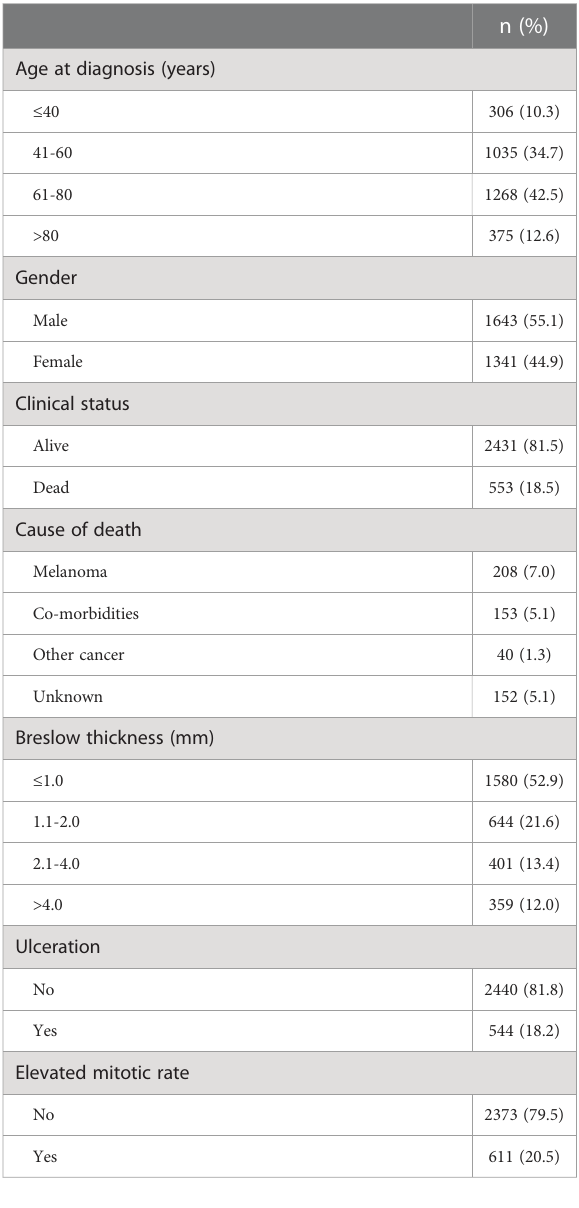
TABLE 1 Patient demographics and clinical